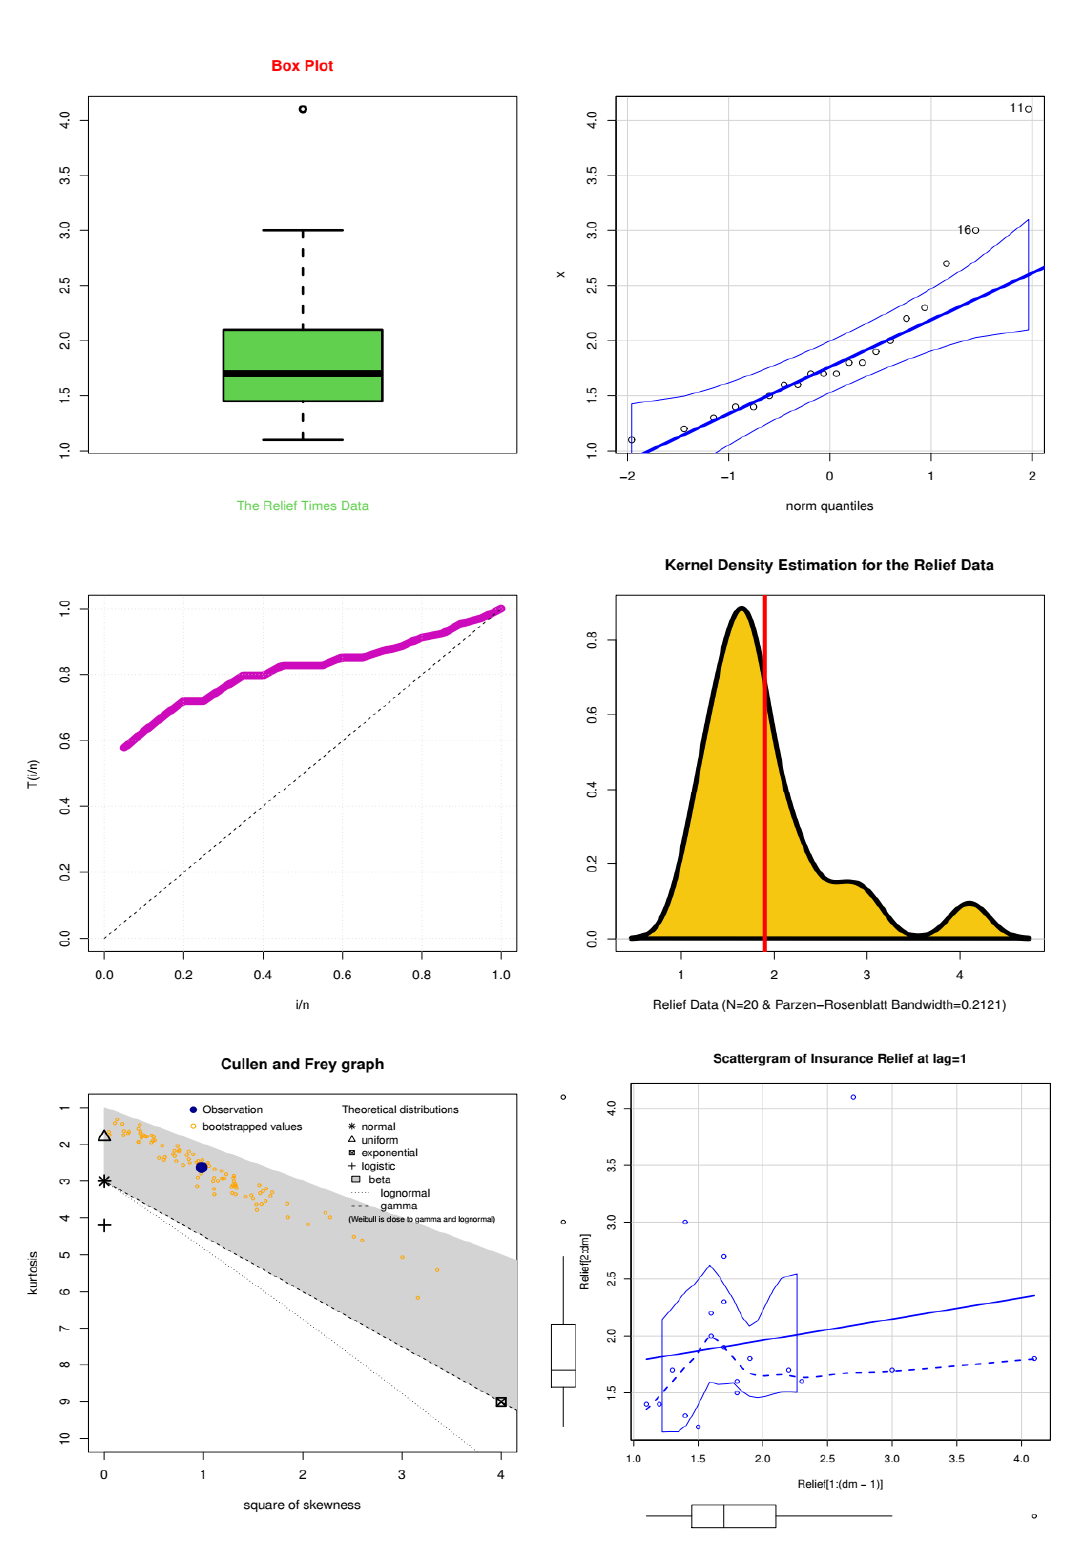
Figure 1. Box plot, Q-Q plot, TTT plot, nonparametric Kernel density estimation, Cullen and Frey, and scattergrams for the relief times.